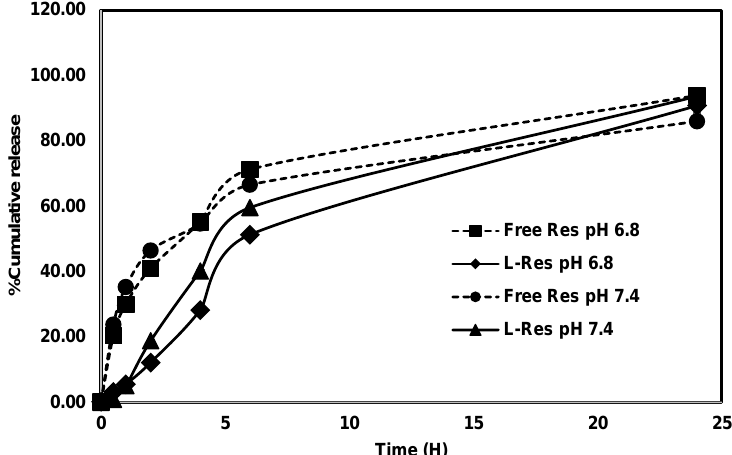
Figure 2. Drug release profile of L-RES. (A) Drug release profiles were assessed using a dialysis bag, molecular weight cut-off of 100 kDa, in phosphate-buffered saline (PBS), pH 7.4, with 1.5% TWEEN 80 at various time points (0 – 24 h). Data are presented as mean ± SD. The graph represents data from two independent experiments. p < 0.05, Student’s t -test.